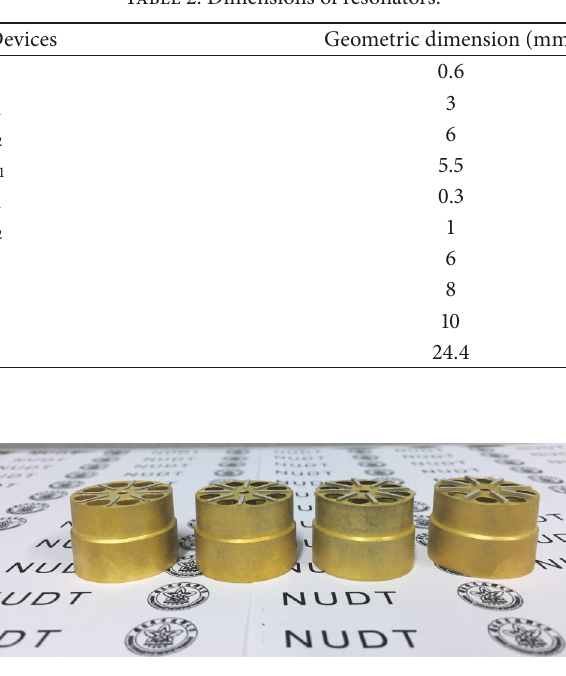
Figure 4: Four resonators attached with piezoelectrodes whose thicknesses are 200 𝜇 m, 400 𝜇 m, 600 𝜇 m, and 800 𝜇 m.